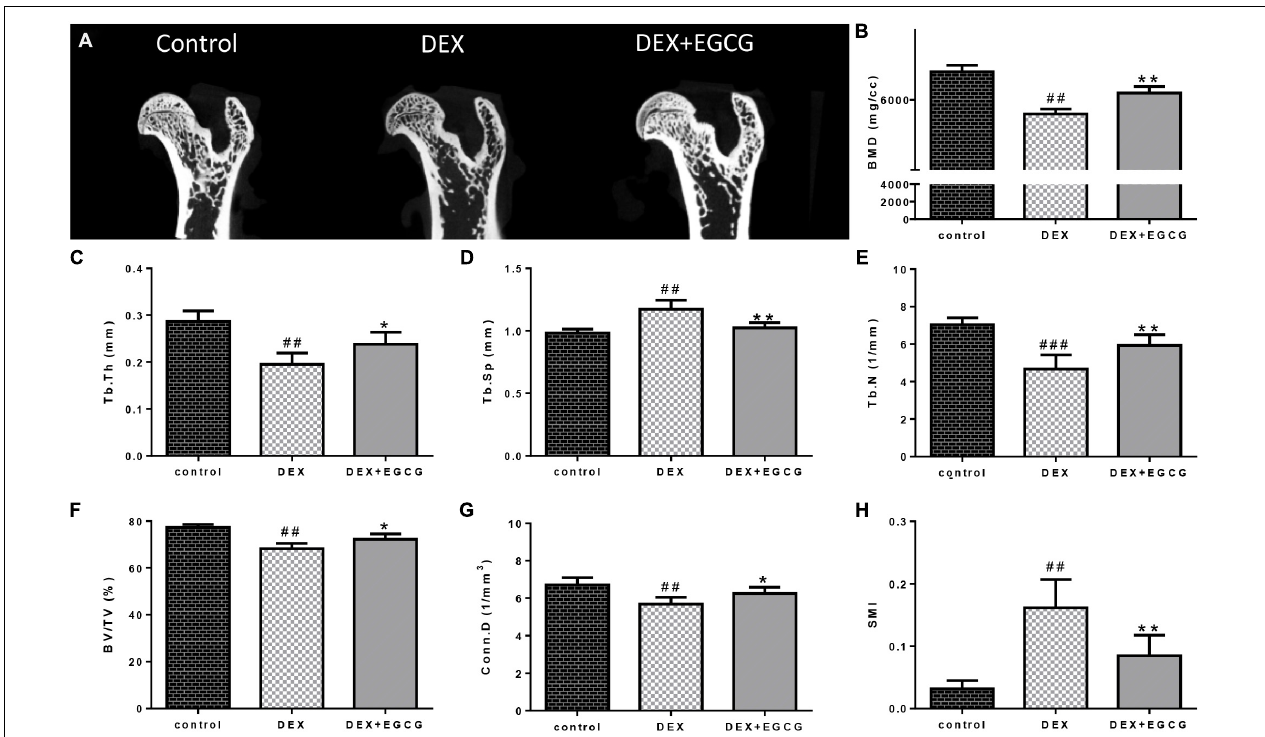
FIGURE 4 | Effects of EGCG on trabecular bone micro-architecture in GIO rats. (A) micro-CT of proximal femurs. (B) Data from BMD measurements of femurs by DXA. The following computed tomographic indices were analyzed in the defined region of interest (ROI): (C) Tb.Th, (D) Tb.Sp, (E) Tb.N, (F) BV/TV, (G) Conn.D, and (H) SMI. The data were expressed as the mean ± SD . ### P < 0.001, ## P < 0.01, # P < 0.05 vs. control and ∗∗ P < 0.01, ∗ P < 0.05 vs.